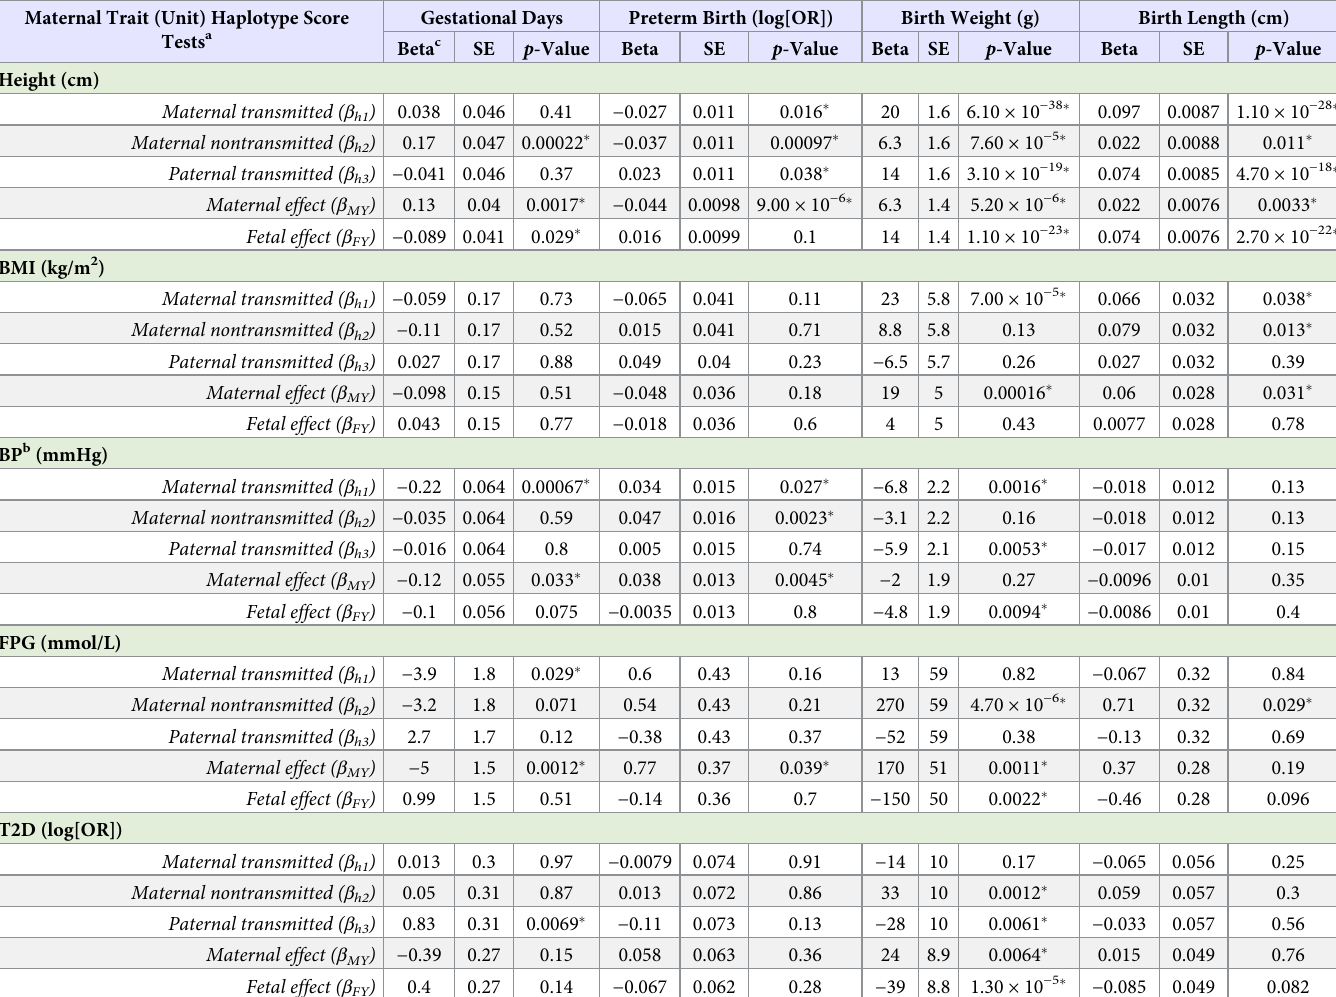
Table 2. Association between haplotype genetic scores and birth outcomes. Maternal Trait (Unit) Haplotype Score Tests